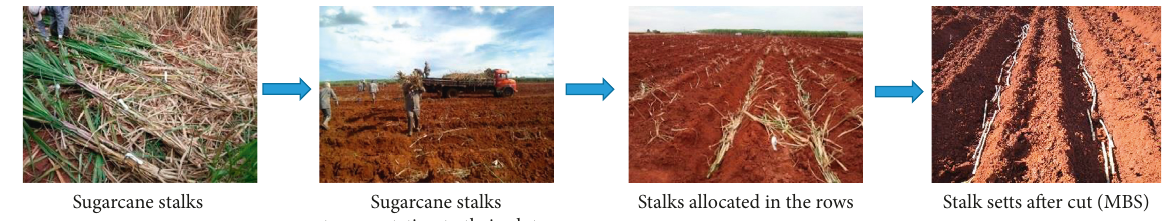
Figure 3: Process for MBS (multibud sett) production and